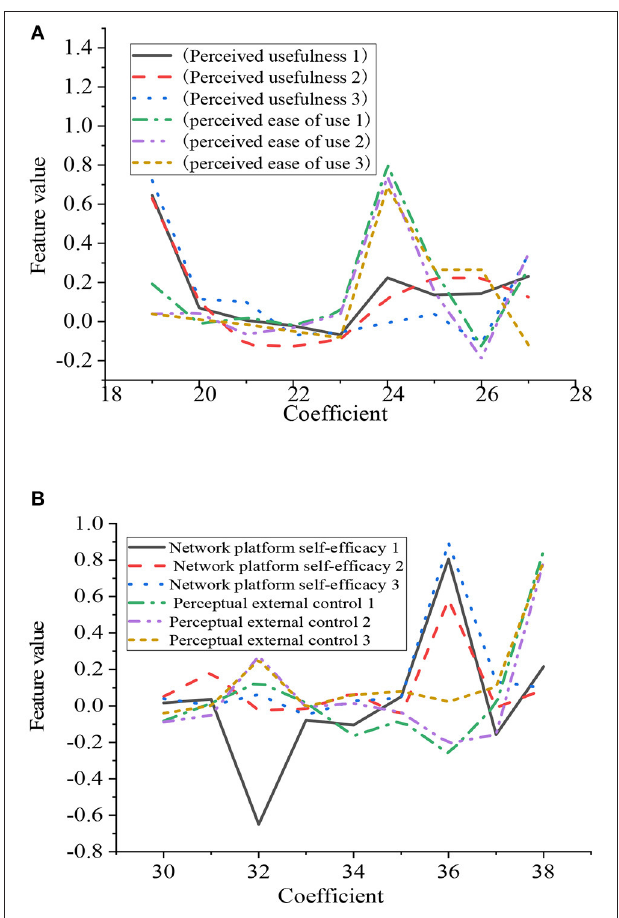
FIGURE 9 | Factor analysis. (A) Perceived usefulness and perceived ease of use. (B) Self-efficacy, perception, and external control of the online